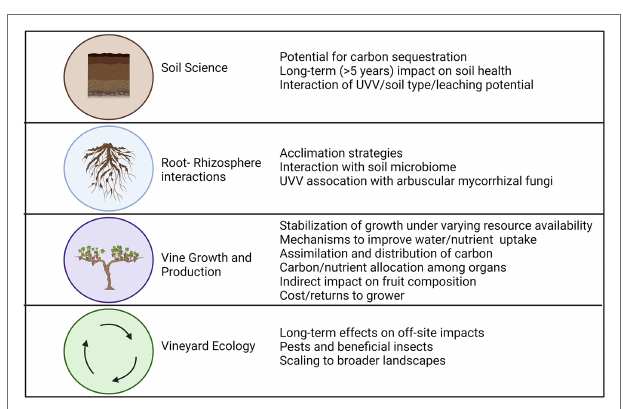
FIGURE 6 | Knowledge gaps and research needs relating to the use of UVV in vineyards. Figure created with